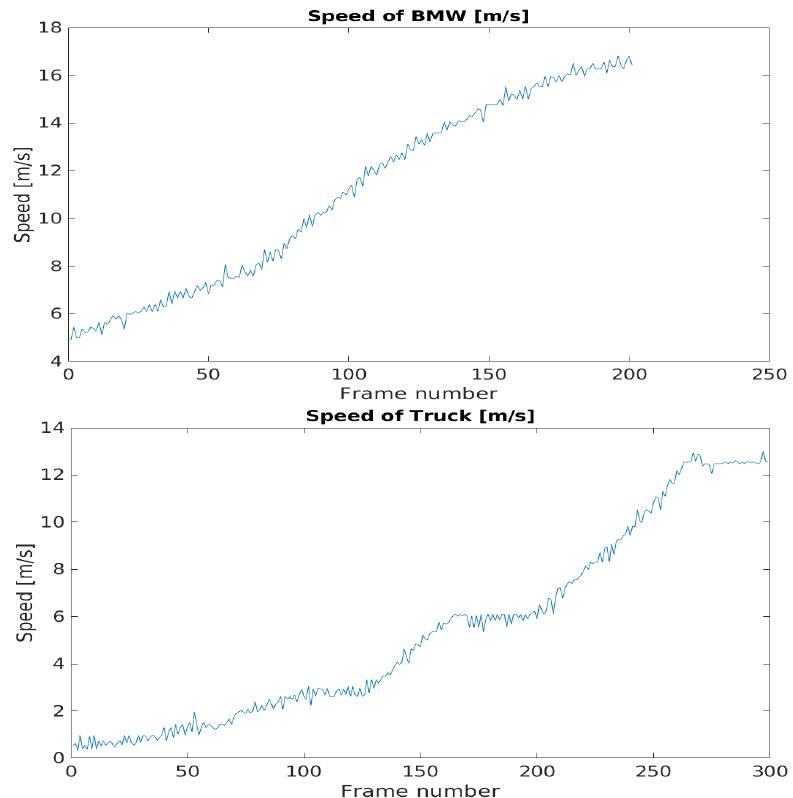
Figure 39. Speed values of the target vehicles: the BMW ( above ) and the Truck ( below ).